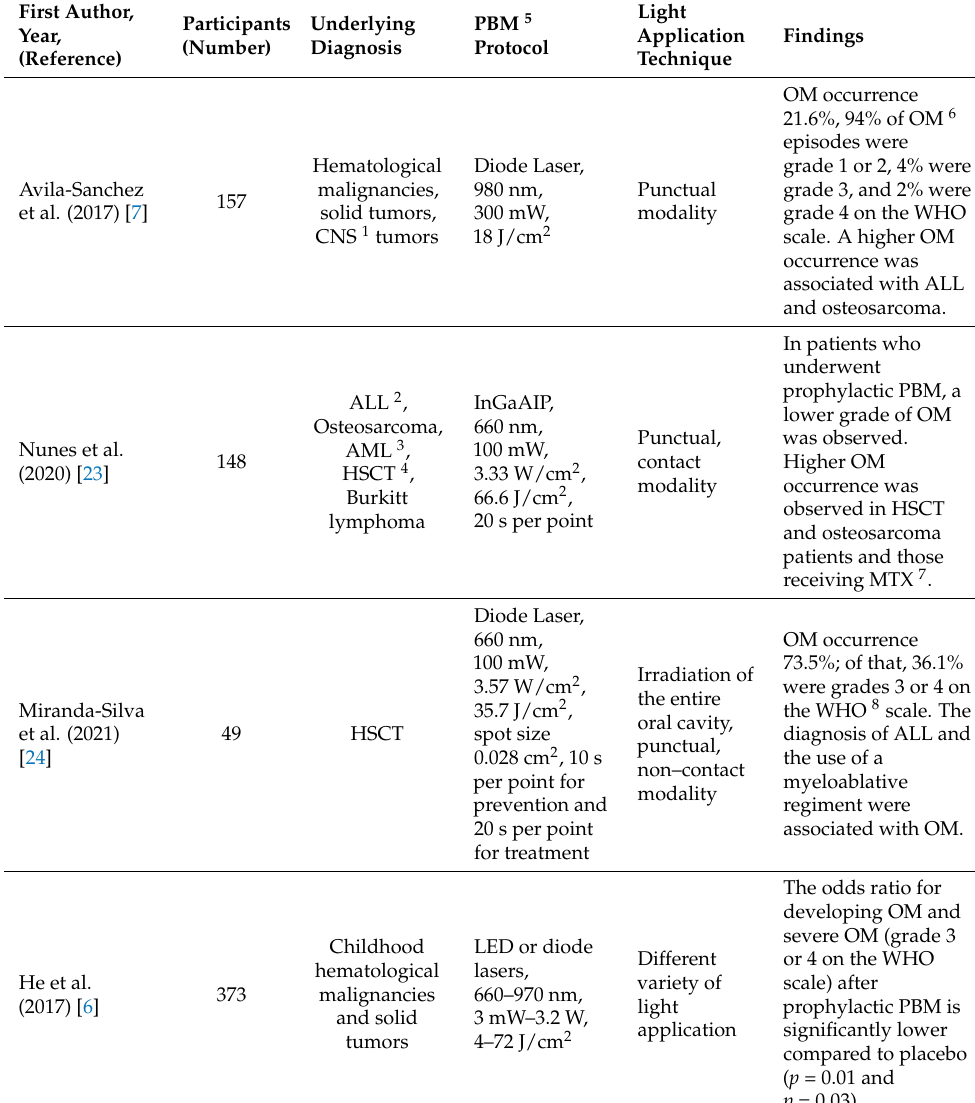
Table 3. Studies addressing PBM in the prevention of chemotherapy-induced OM in